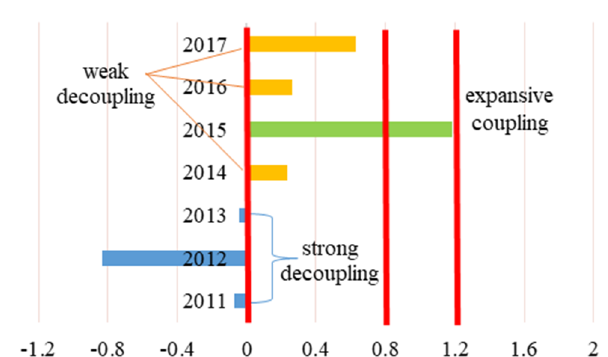
Figure 7. Degrees of coupling and decoupling of CO 2 emissions growth ( ∆ CO 2 ) from economic growth ( ∆ GDP) for Changxing County from 2011 to 2017.